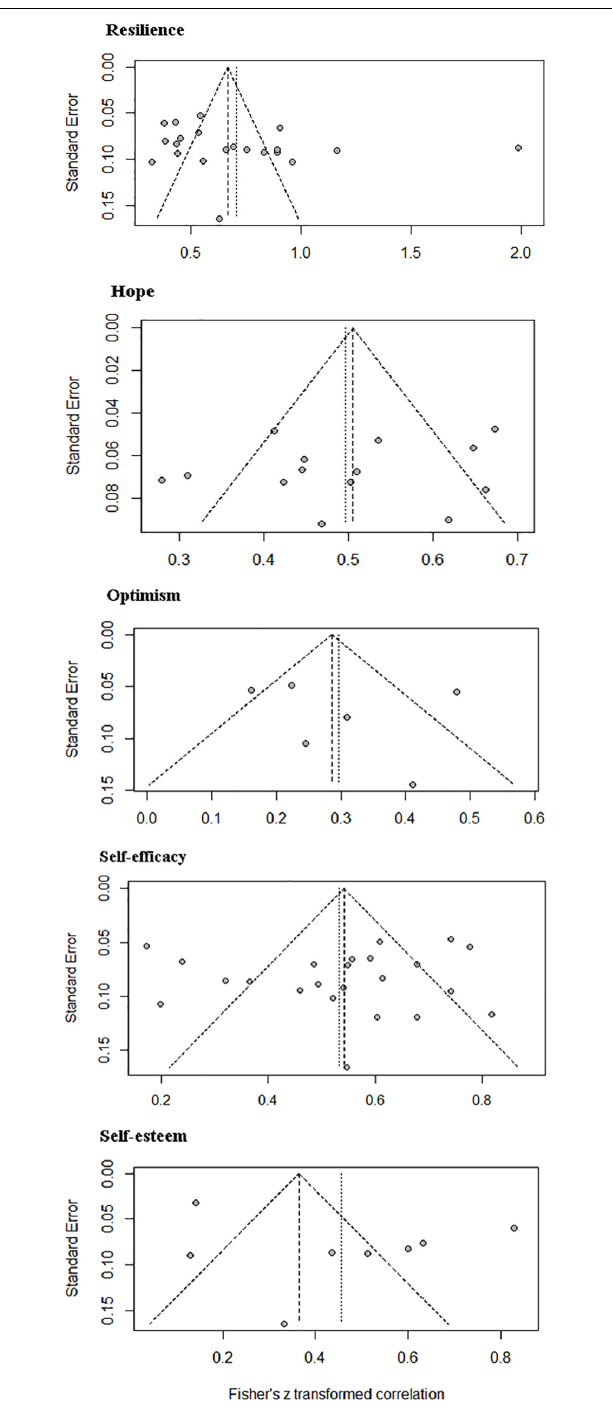
FIGURE 3 | Publication bias based on the funnel